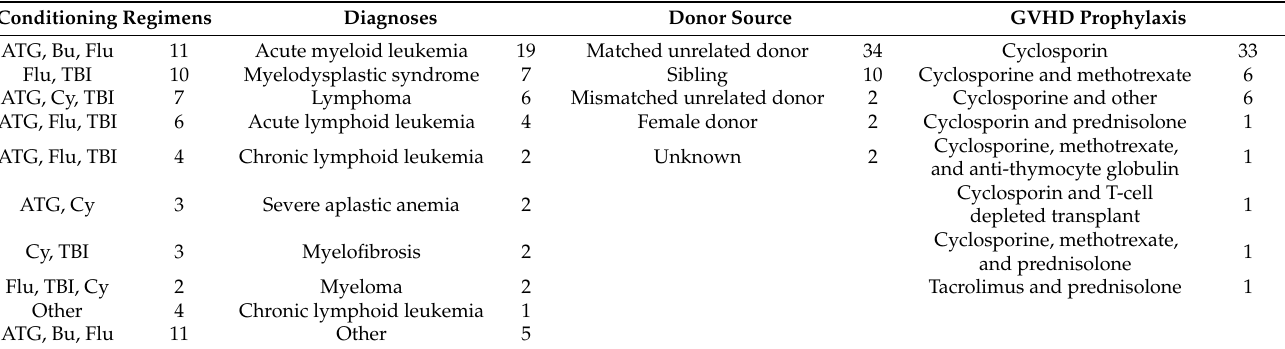
Table 1. Patient characteristics ( n =